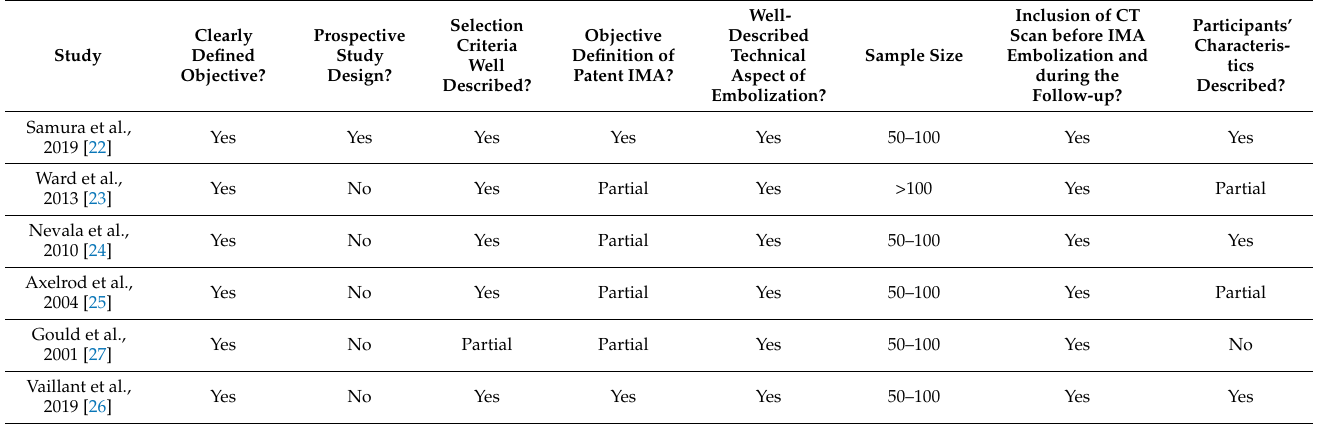
Table 5. Strengths and weaknesses of studies included in this systemic review. IMAE, inferior mesenteric artery embolization